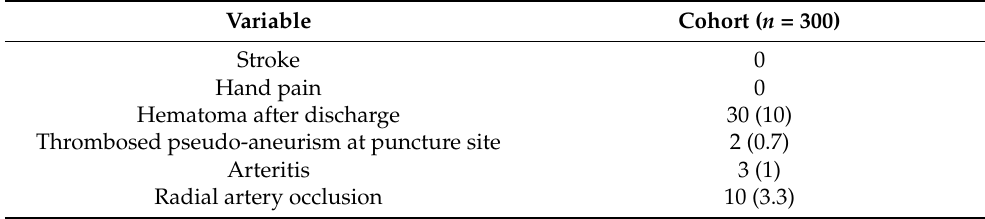
Table 3. Access site adverse